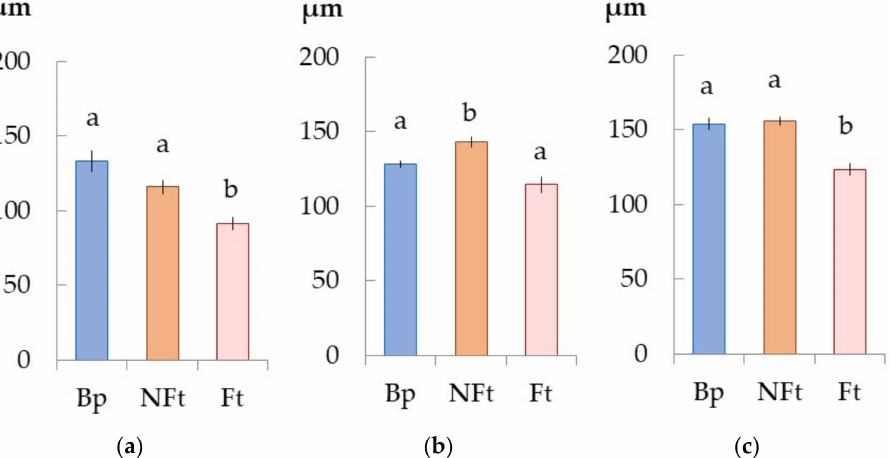
Figure 3. The width of the conductive phloem of B. pendula var. pendula (Bp), non-figured (NFt), and figured (Ft) B. pendula var. carelica trees. Samples were collected on 28 May 2020 ( a ), 11 June 2020 ( b ), and 25 June 2020 ( c ). n = 9.